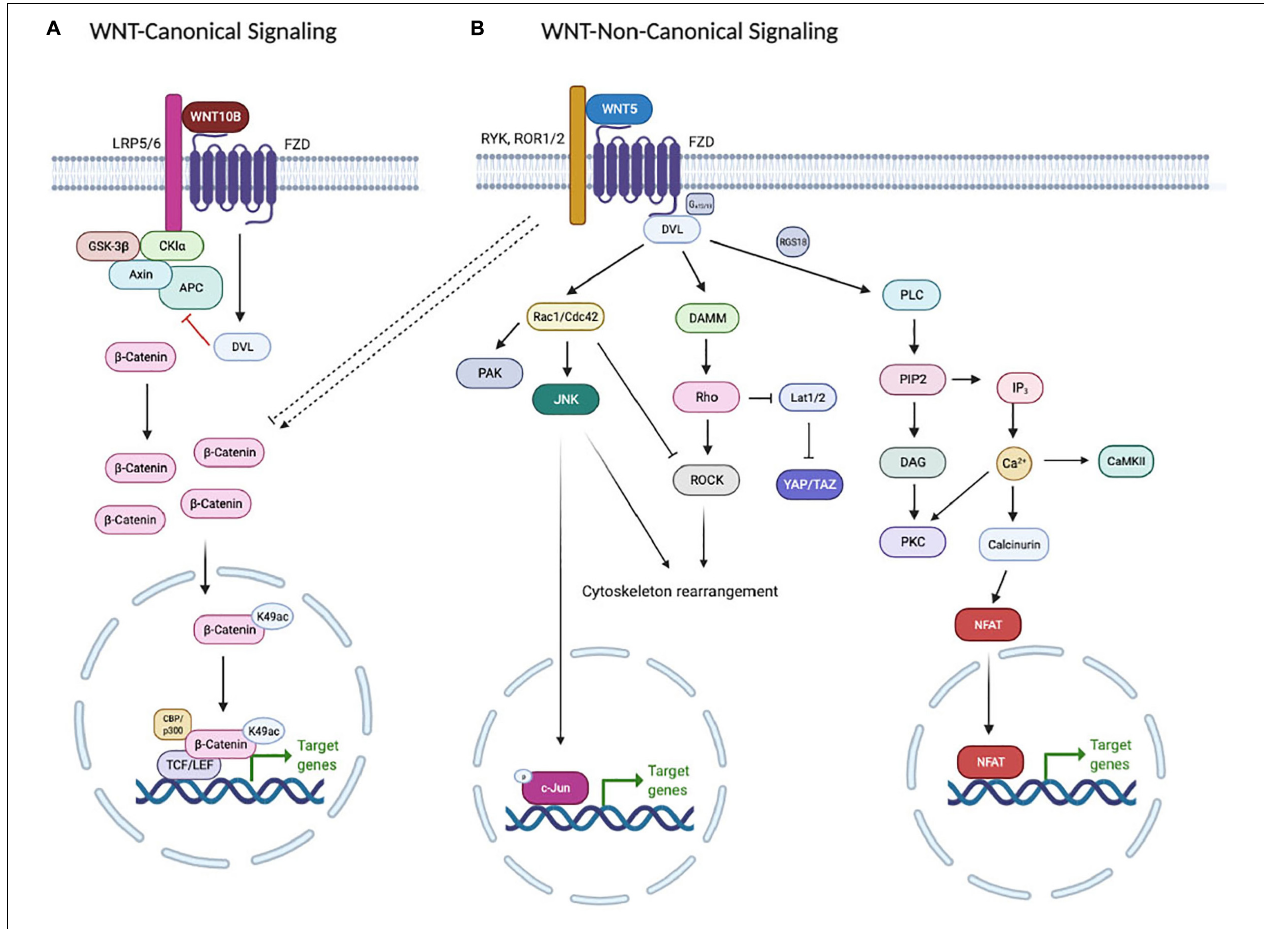
FIGURE 1 | WNTs can signal through (A) β -catenin-dependent (or canonical) WNT signaling, (B) WNT-PCP signaling or WNT-Ca 2 + signaling. See the text for details.